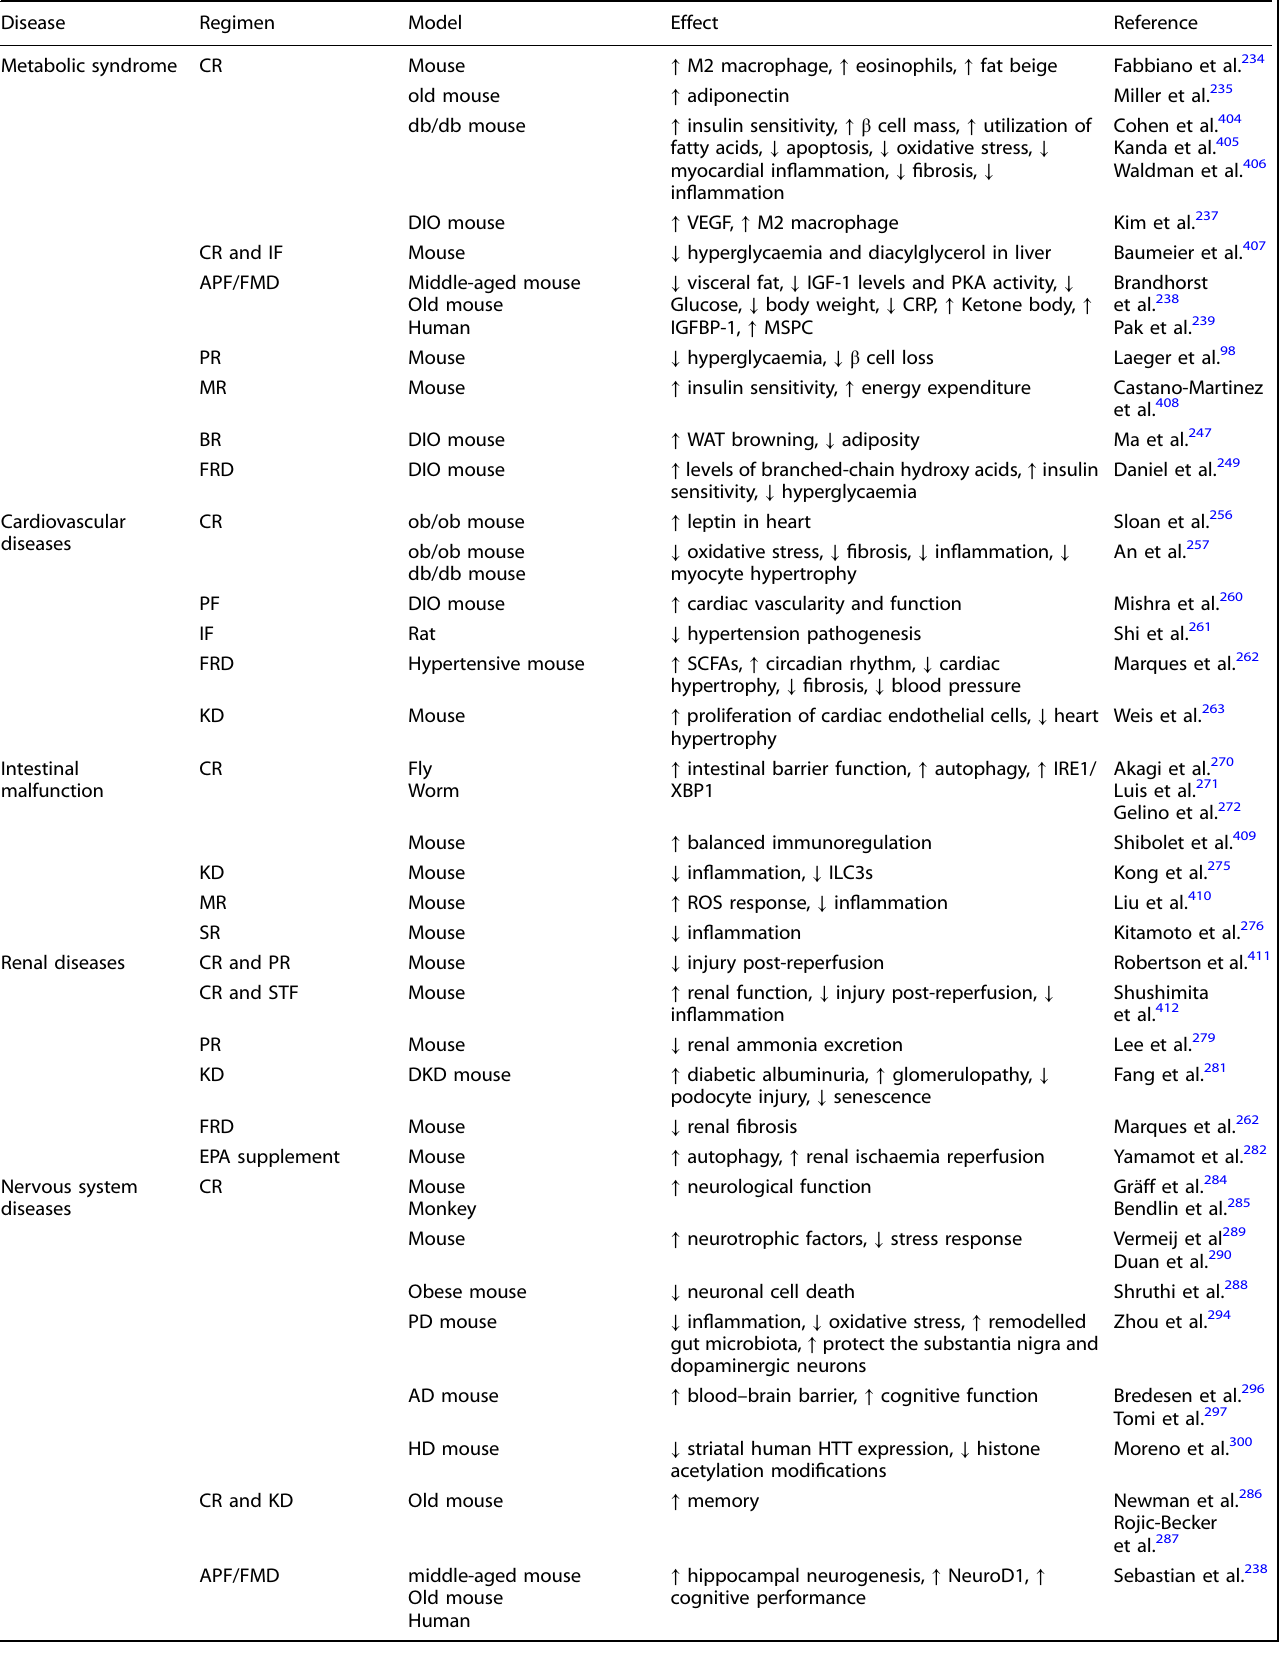
Table 3. The roles of dietary interventions in disease models